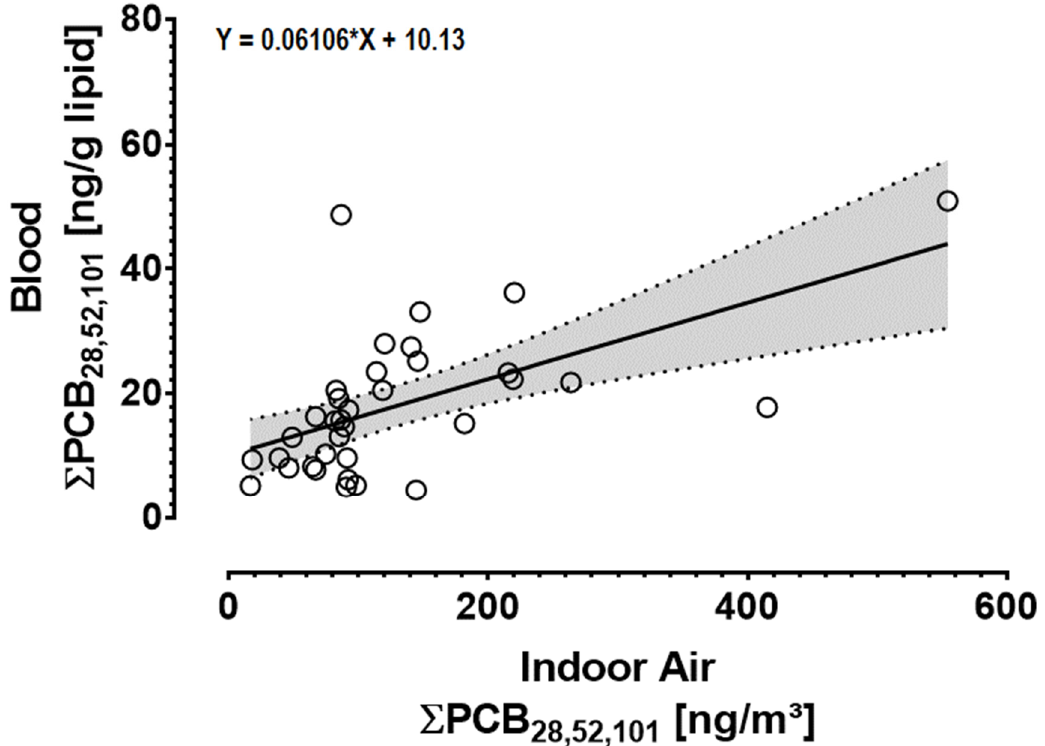
Figure 3. Linear regression between ∑ PCB 28,52,101 in indoor air and ∑ PCB 28,52,101 in blood ( n = 35) (R 2 = 0.33, F(1,33) = 16.28; p < 0.001). The solid line is the regression line superimposed over a scatter plot of the data and the dotted lines show the 95% confidence interval of the fit.